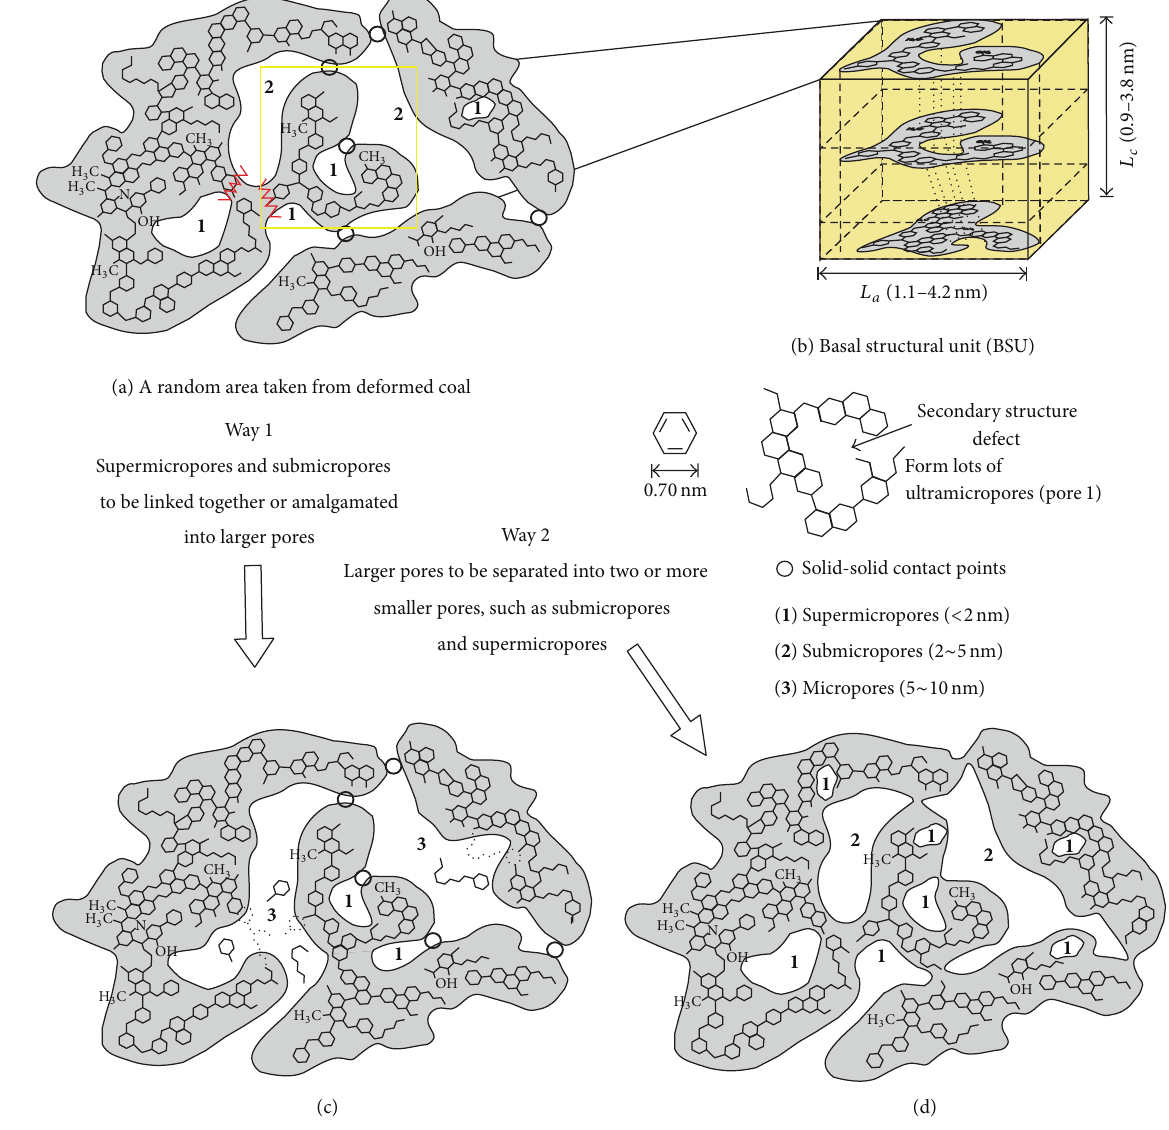
Figure 9: Evolutionary process of nanopore structure in deformed coal. (a) A random area taken from deformed coal. The black circle indicates a solid-solid contact point in deformed coal, number “1” means supermicropores, and number “2” means submicropores; (b) three- dimensional diagram of a small area which was magnified; (c) way 1 of interconversion among the different size nanopores: the parts of the smaller pores become connected or linked together and gradually grow into larger pores. Number “3” means micropores. (d) Way 2: larger pores being separated into two or more smaller